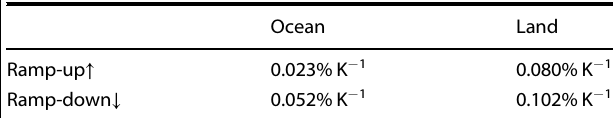
Table 2. Summary of SDs of apparent hydrological sensitivity ( κ ) in 28 CESM1 ensemble